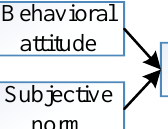
Figure 2. Rational Behavior Theory Model.